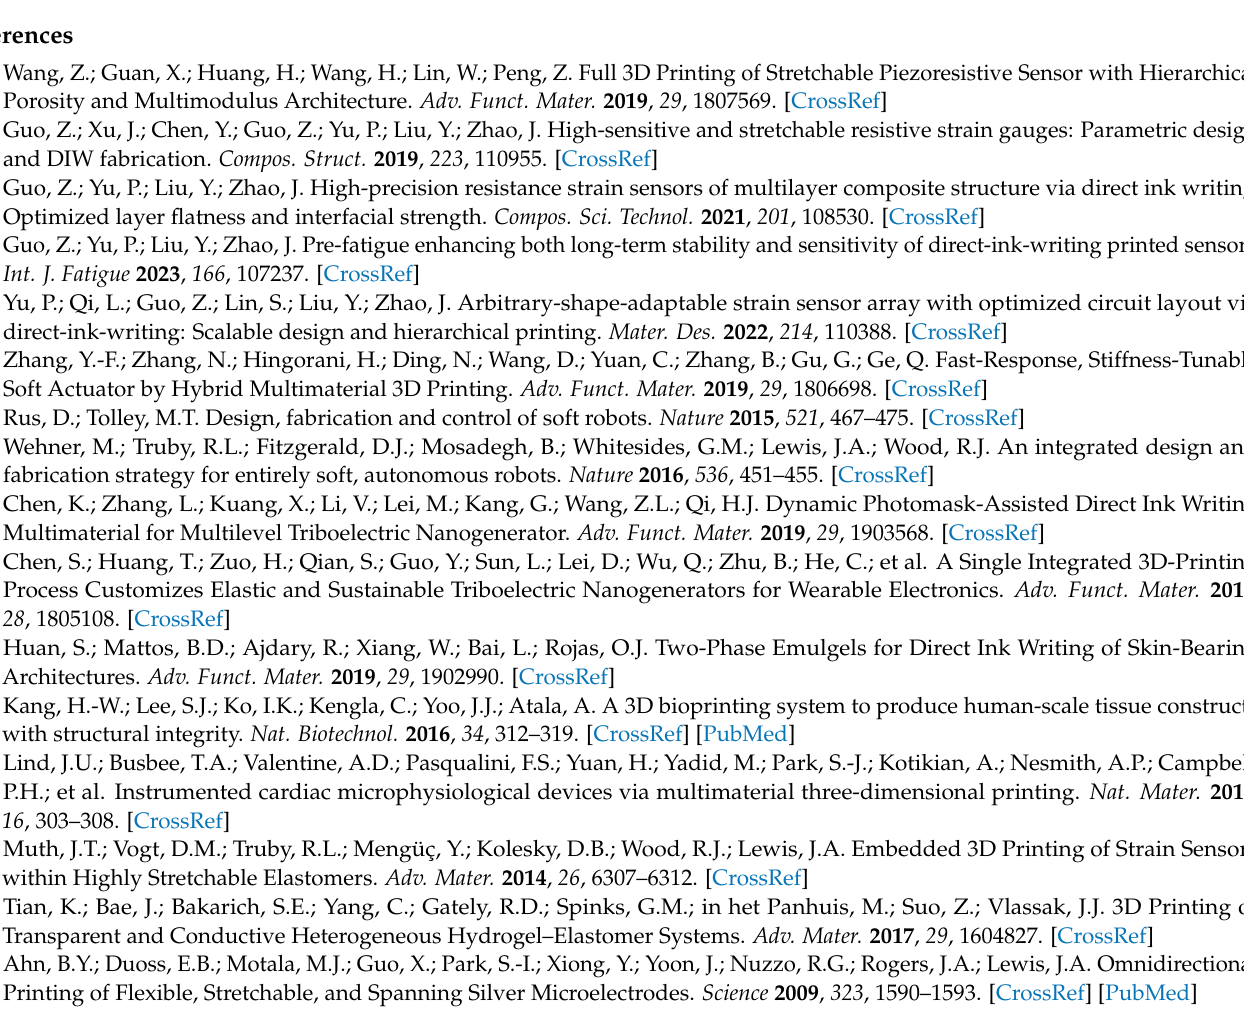
cross-section of ink lines after curing; Figure S5: Optical images at lower magnification of ink layers printed with silver paste and carbon paste (CH-8,